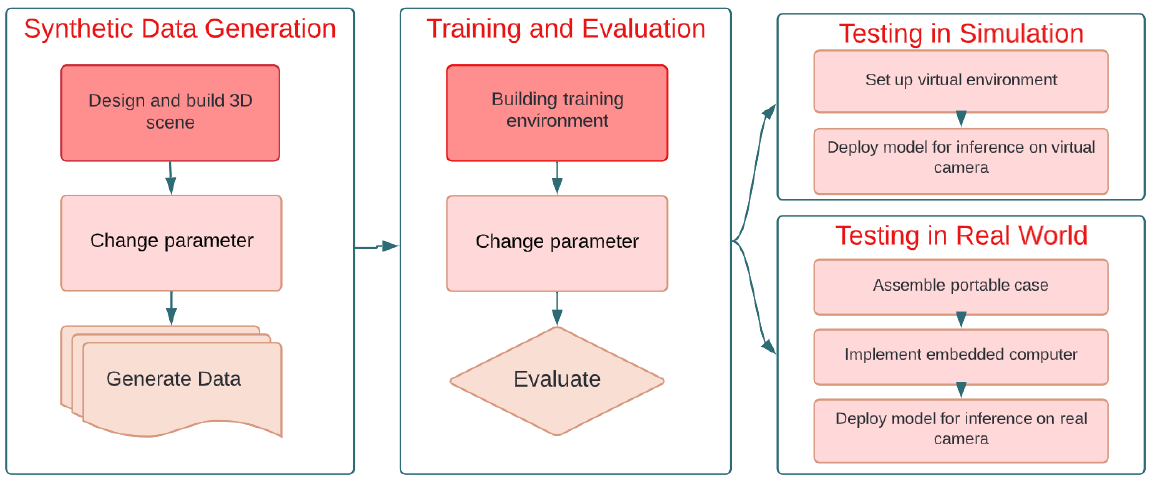
Figure 1. The research approach for creating an object detection system is trained on purely synthetic